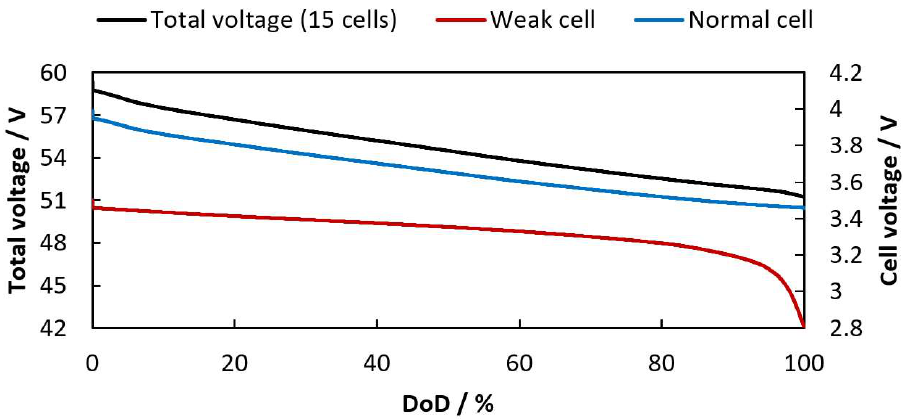
Figure 9. Voltage of the battery pack to which 15 cells are connected (left Y-axis), voltage of one normal cell (right Y-axis), and voltage of the weak cell (right Y-axis) discharged until reaching EoD. In Figure 9, a black solid line represents the voltage of a battery pack to which 15 cells are connected in series, and the left Y-axis represents the voltage of the battery pack. The solid red line indicates the weak cell voltage, and the cell voltage is indicated on the right Y-axis. Lastly, the solid blue line represents the voltage of one normal